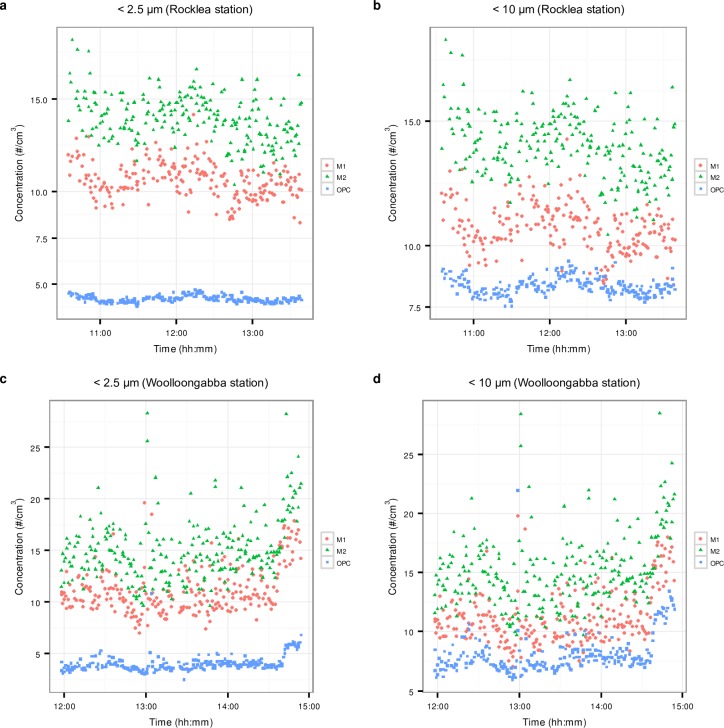
Time series of ambient particles number concentrations.a) Rocklea station, particles in the size range: M1 ≤ 2.5 μm, M2 ≤ 2.5 μm and OPC ≤ 2.1 μm. b) Rocklea station, particles in the size range: M1 ≤ 10 μm, M2 ≤ 10 μm and OPC ≤ 7 μm. c) Woolloongabba station, particles in the size range: M1 ≤ 2.5 μm, M2 ≤ 2.5 μm and OPC ≤ 2.1 μm. d) Woolloongabba station, particles in the size range: M1 ≤ 10 μm, M2 ≤ 10 μm and OPC ≤ 7 μm.